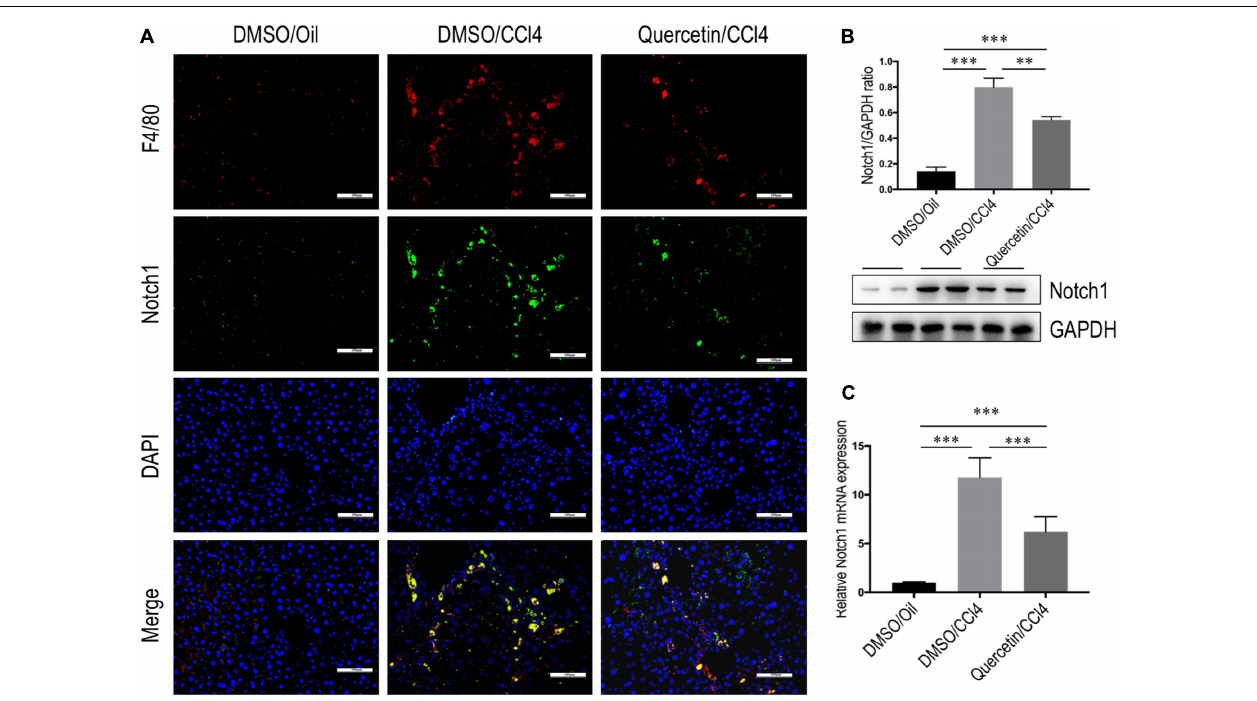
FIGURE 8 | Quercetin inhibited hepatic Notch1 expression in CCl 4 -treated mice. (A) Immunofluorescent double staining of Notch1 in liver sections from each group. Livers were double stained for Notch1 (green) and F4/80 (Red) macrophages; DAPI as blue nuclear counterstain. Scale bar = 100 µ m. (B) Western blotting analysis of Notch1 expression in lysed liver tissues, with results normalized relative to the expression of GAPDH ( n = 3). (C) Hepatic Notch1 mRNA expression was measured by quantitative RT-PCR. Results are shown as fold change compared with oil-treated control and GAPDH served as loading control ( n = 5). ∗∗ P < 0.01; ∗∗∗ P <